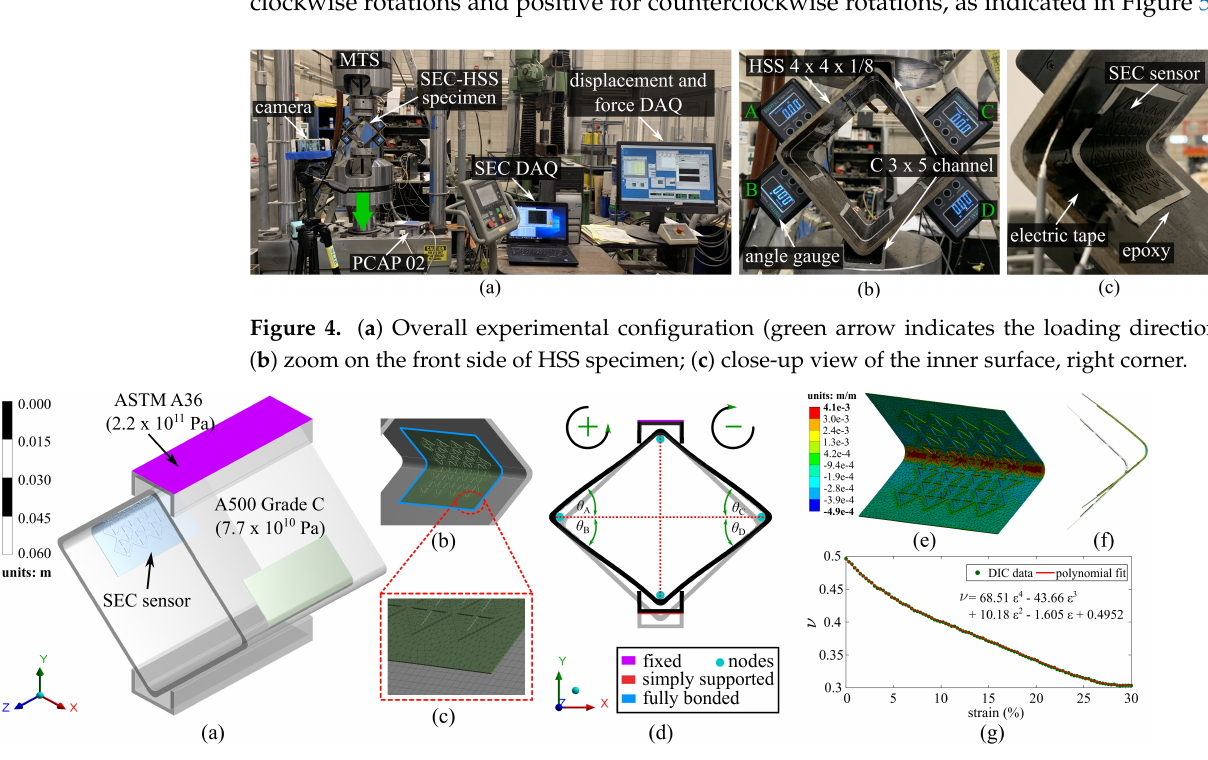
Figure 5. ( a ) Schematic of the numerical model showing the general geometry and of the HSS specimen; ( b ) boundary conditions of the cSEC; ( c ) mesh type and mesh distribution; ( d ) simulated deformation and boundary conditions of the HSS specimen; ( e ) normal elastic distribution of the cSEC within a folded configuration; ( f ) front section view of the sensor showing the deformation under angular motion; ( g ) strain-dependent nonlinear transverse Poisson’s ratio of